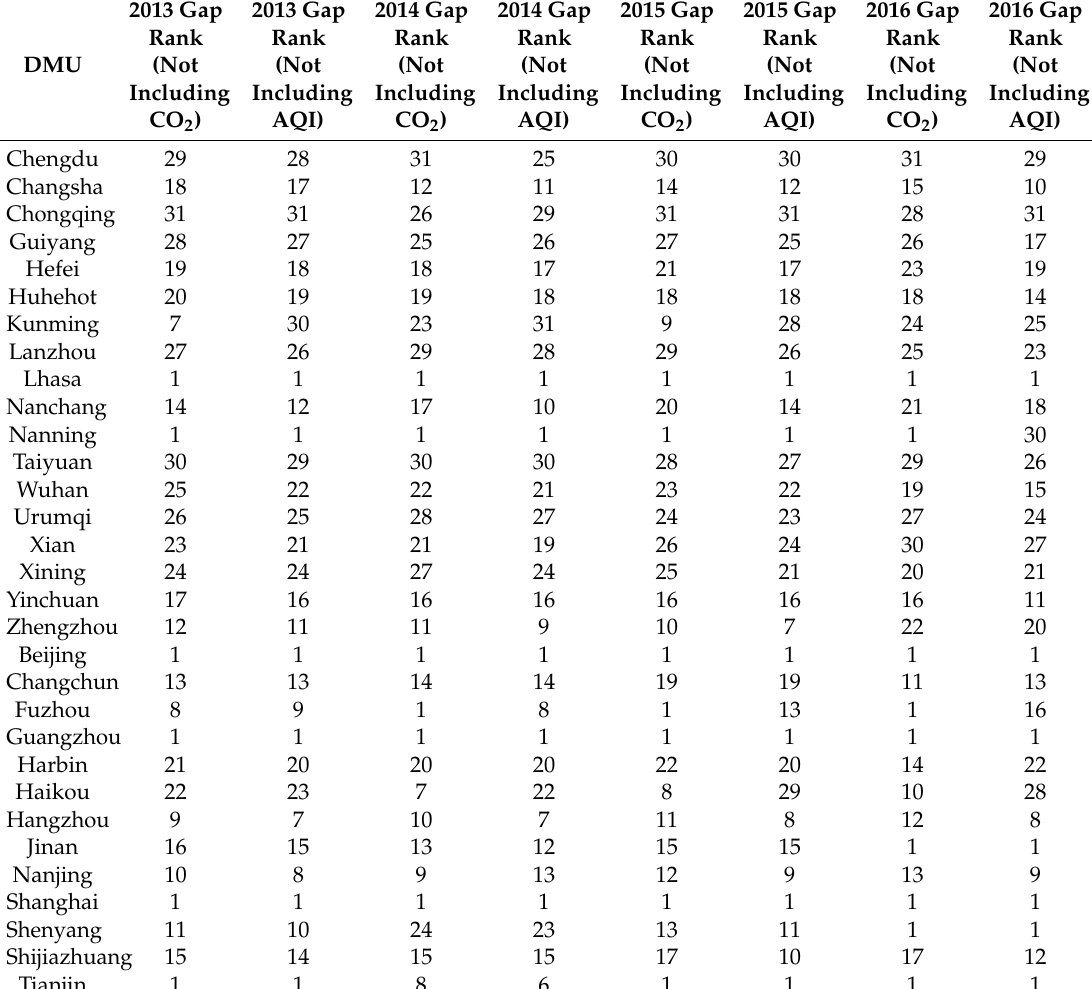
Table 6. CO 2 and AQI gap